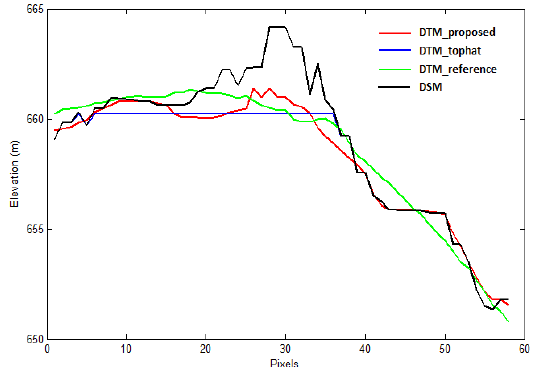
Figure 8. Profile comparison between the DTMs along the red line in Figure 6a (Black: original DSM; Red: generated DSM; Blue: tophat morphological reconstruction; Green: reference